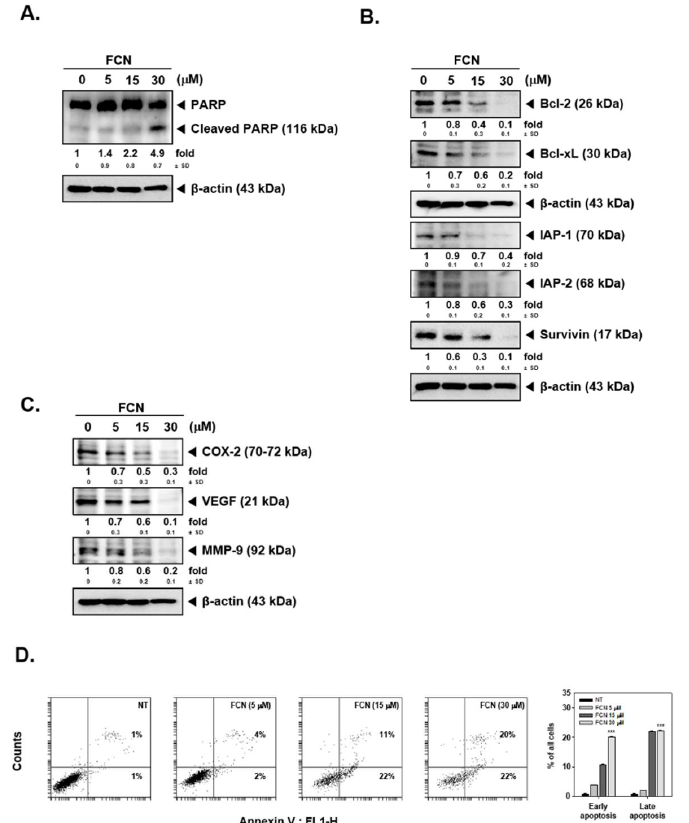
Figure 5. FCN induced apoptosis in U266 cells. U266 cells were treated with FCN (0, 5, 15, and 30 μM) for 24 h. Whole cell lysates were prepared to analyze the expression of ( A ) PARP and ( B ) various oncogenic gene products such as Bcl-2, Bcl-xl, IAP-1, IAP-2, survivin, as well as ( C ) COX-2, VEGF, and MMP-9. ( D ) FCN-induced apoptosis in U266 cells was analyzed by annexin V assay. Cells were treated with FCN for 24 h. The results shown are representative at least three independent experiments.